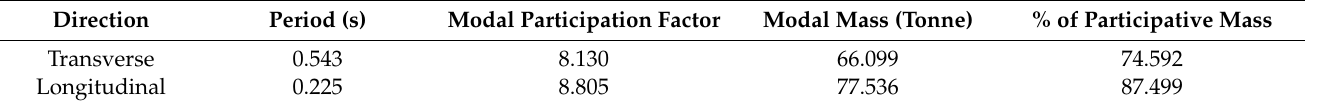
Table 3. Predominant modes of vibration in each direction of the structure.